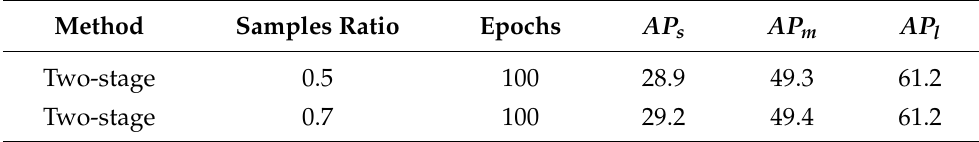
Table 2. Comparison with samples